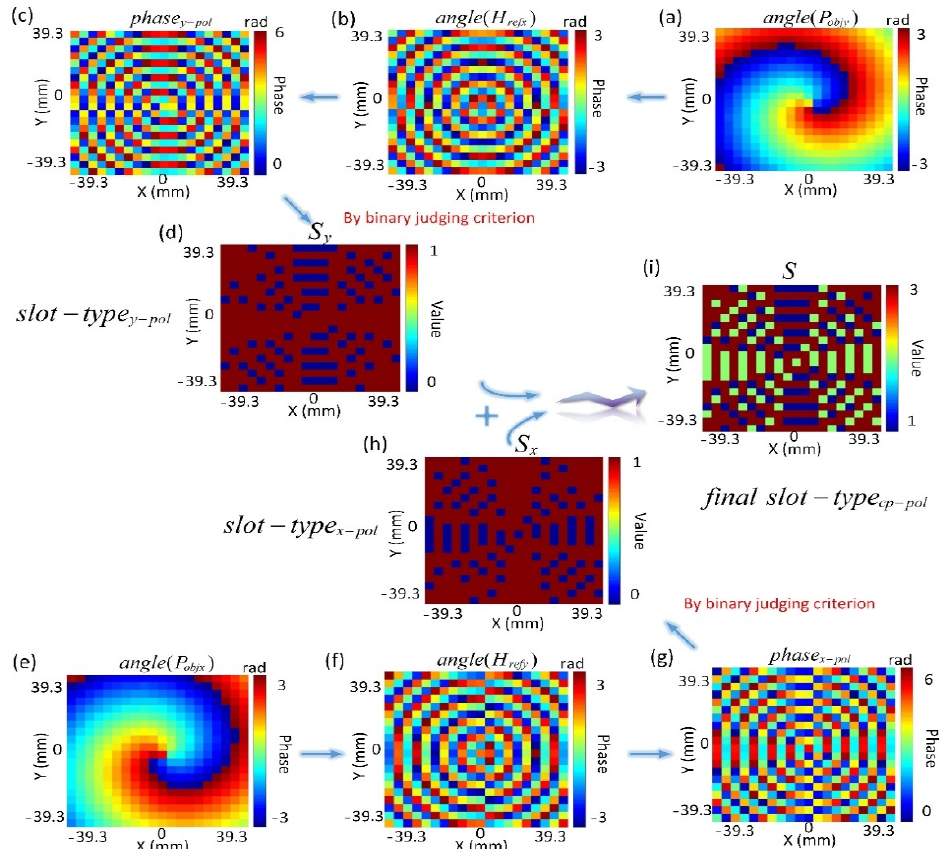
Figure 3. Scheme of the calculation process of the final slot-type distribution pattern. Phase distribution patterns of the ( a , e ) object waves, ( b , f ) reference waves, and ( c , g ) inferograms with the y- and x-polarization, respectively. Slot-type distribution patterns of the ( d ) y-, ( h ) x- and ( i ) left-handed circularly polarized quasi-non-vortex waves, respectively.